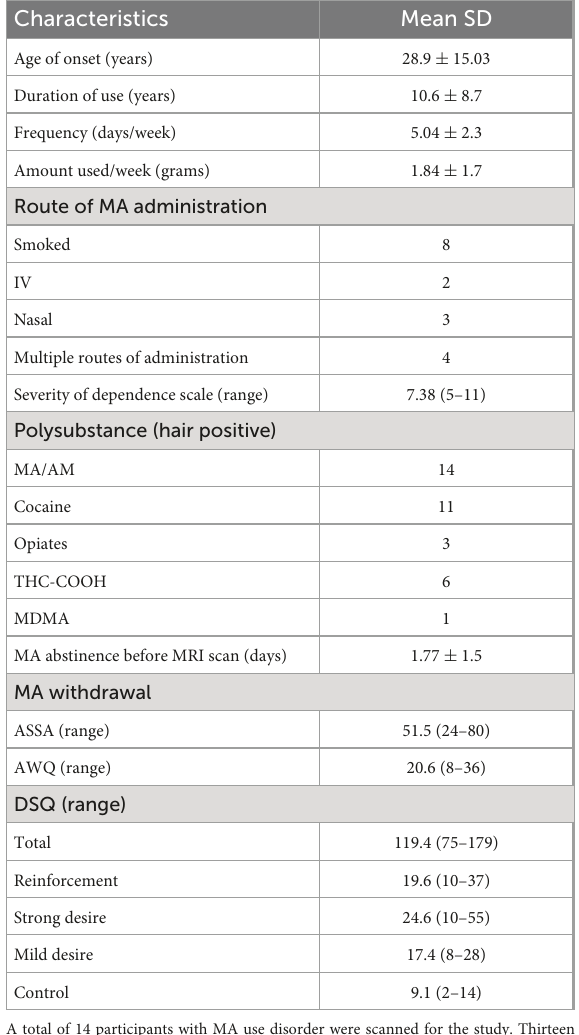
TABLE 2 Methamphetamine (MA) use characteristics ( n =